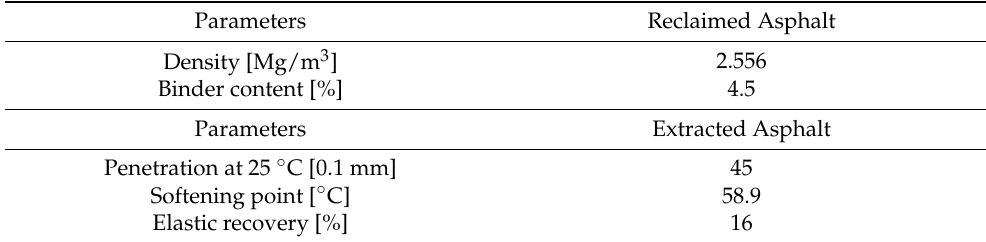
Table 4. Parameters of reclaimed asphalt.